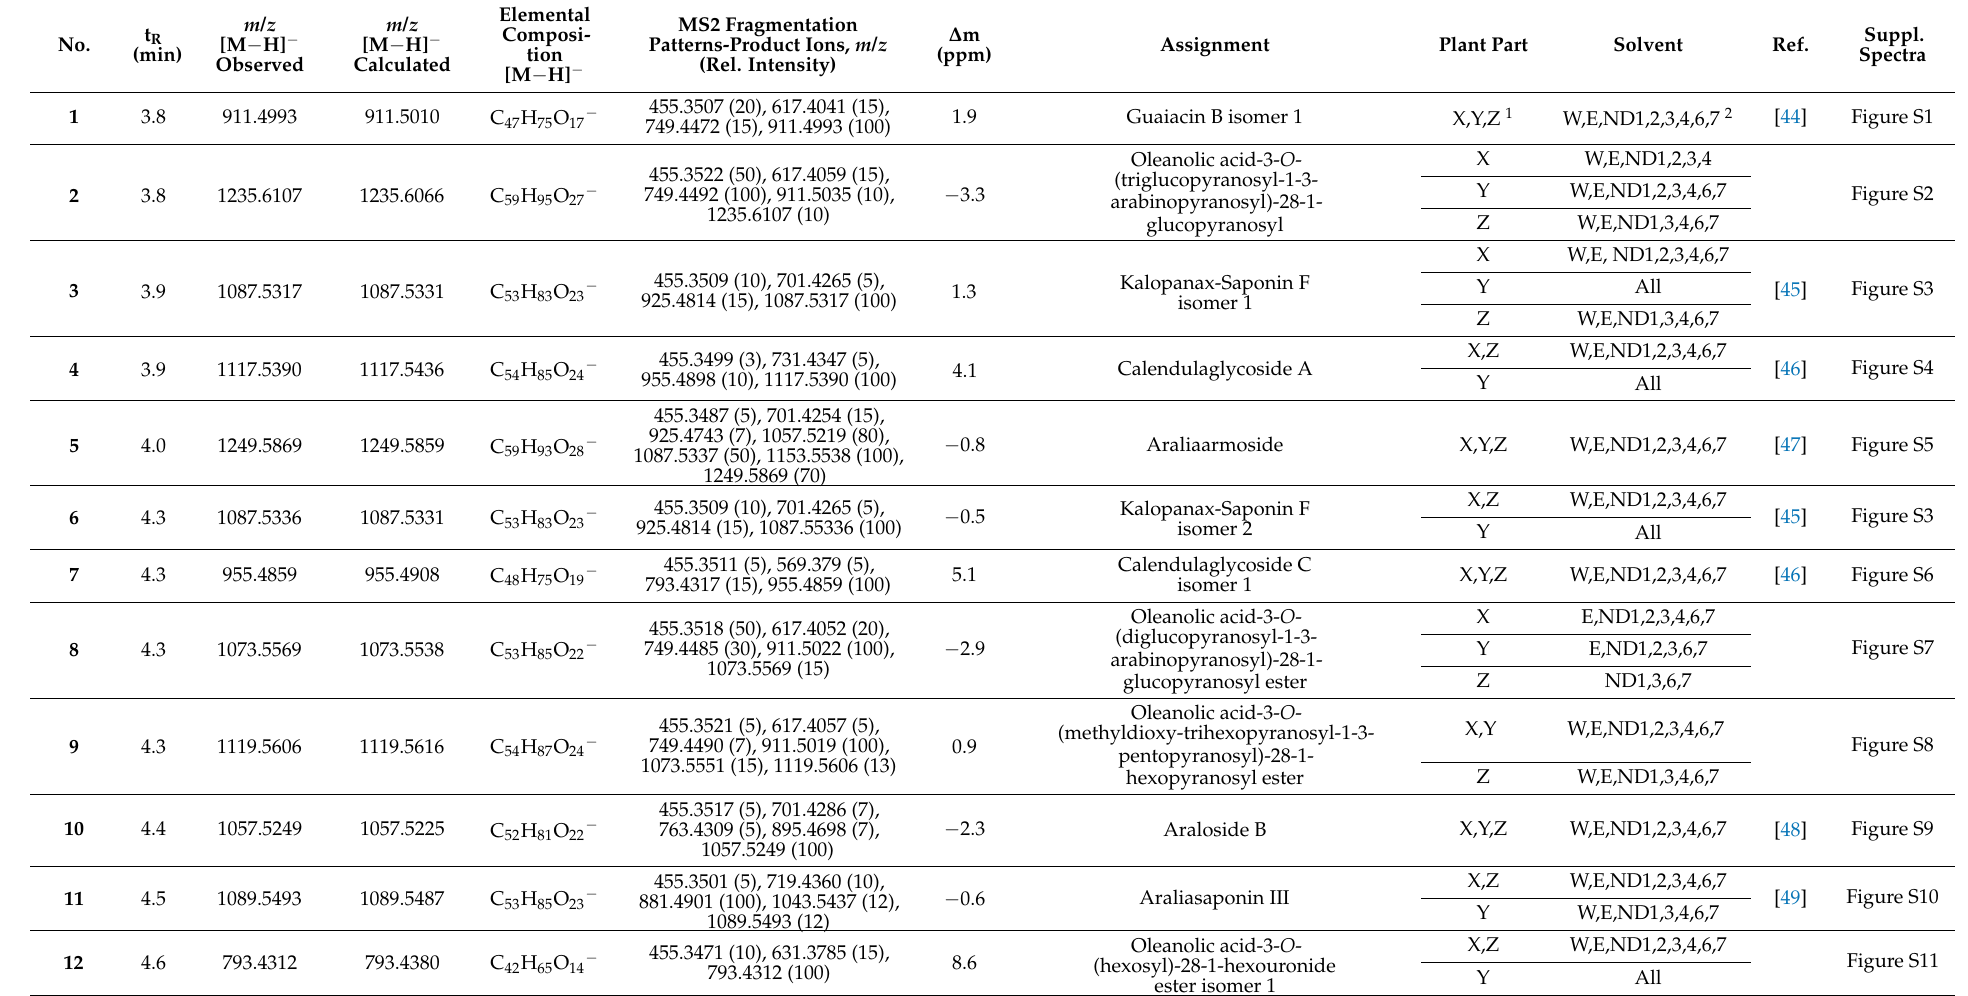
Table 1. Targeted metabolites annotated in different parts of the root of A. elata var. mandshurica (Rupr. & Maxim.) J. Wen extracted using conventional and